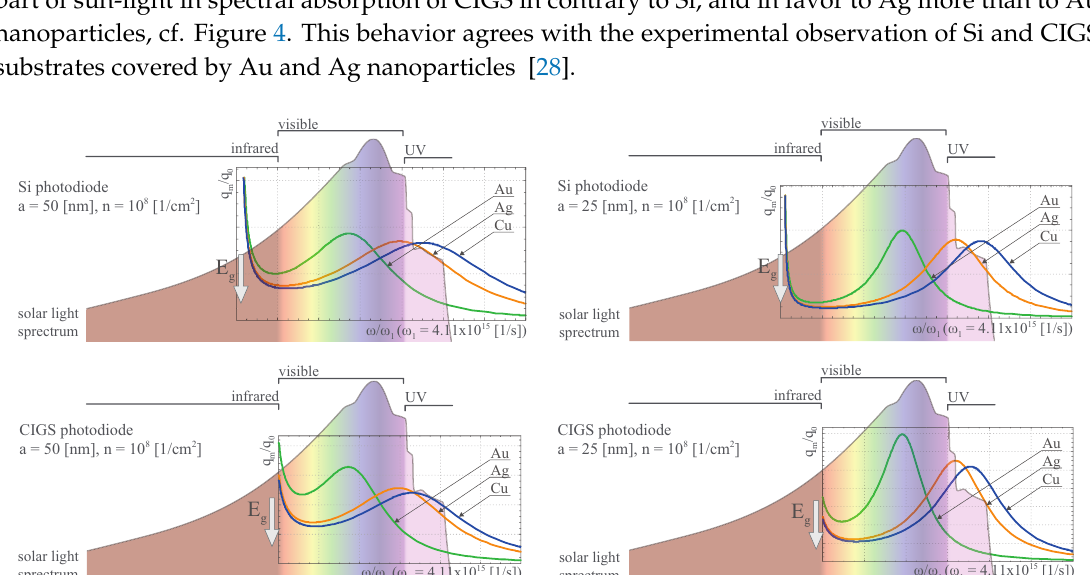
Figure 4. Comparison of the effectiveness of the plasmon channel expressed by q m Equation (18)) for the same substrate semiconductor Si ( upper ) and CIGS ( lower ) with Au (red), Ag (blue) and Cu (green) nanoparticles of the same radius of 50 nm ( left ), 25 nm ( right ) and the same surface density 10 8 /cm 2 , versus the sun-light spectrum on the earth surface—the figure illustrates accommodation of the spectral characteristics of the plasmon-mediated photo-effect, q m spectrum for different materials and covering parameters; arrows indicate the positions of the forbidden gap for Si and CIGS, respectively, marked on the background of the solar light spectrum; the latter accommodated to the frequencies ω / ω 1 on the horizontal axis, the vertical axis shows the efficiency growth on the same scale for Au, Ag and Cu not related to the vertical height of the solar